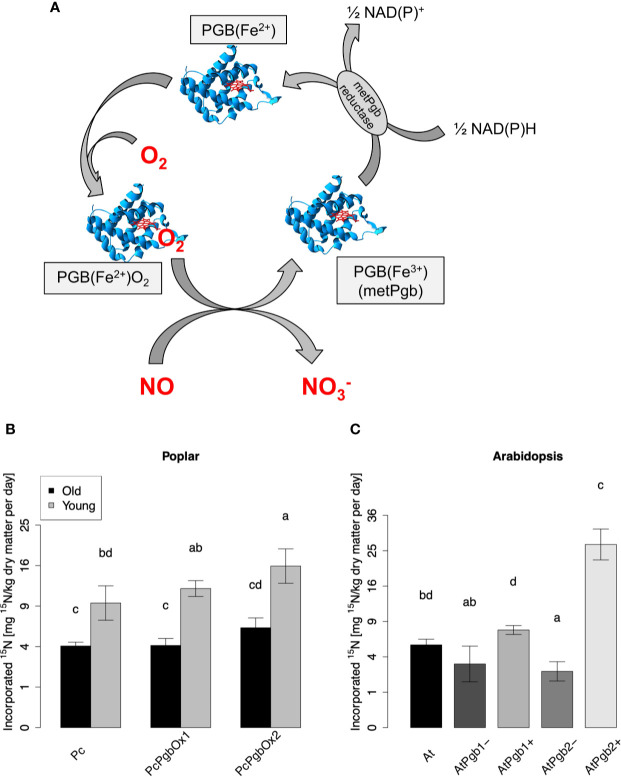
NO-fixation by plant phytoglobin. (A) Illustration of the biochemical NO-fixing reaction mechanism. NO is converted to nitrate (NO3
-) by the oxygenated ferrous phytoglobin [PGB(Fe2+)], which turns to the metPgb form [PGB(Fe3+)]. The latter is reduced by a NAD(P)H-dependent reductase (metPGB) and then oxygenated again. (B)
15N content in transgenic poplar and (C)
Arabidopsis determined 5 days after fumigation with 50 ppbv of 15NO. In (B) leaves of old (40 day-old) and young (15 day-old) poplar tree have been analyzed. Each plot depicts means ± SD. Four samples of Arabidopsis and old poplar trees were measured (n = 4) and three samples of the young poplar trees were measured (n = 3). 15N content values are shown after square root transformation. Different letters indicate significant differences according to Tukey’s posthoc test (p < 0.05) after significant ANOVA (p < 0.001; Shapiro-Wilk test: p > 0.05; Levene’s test: p > 0.05).